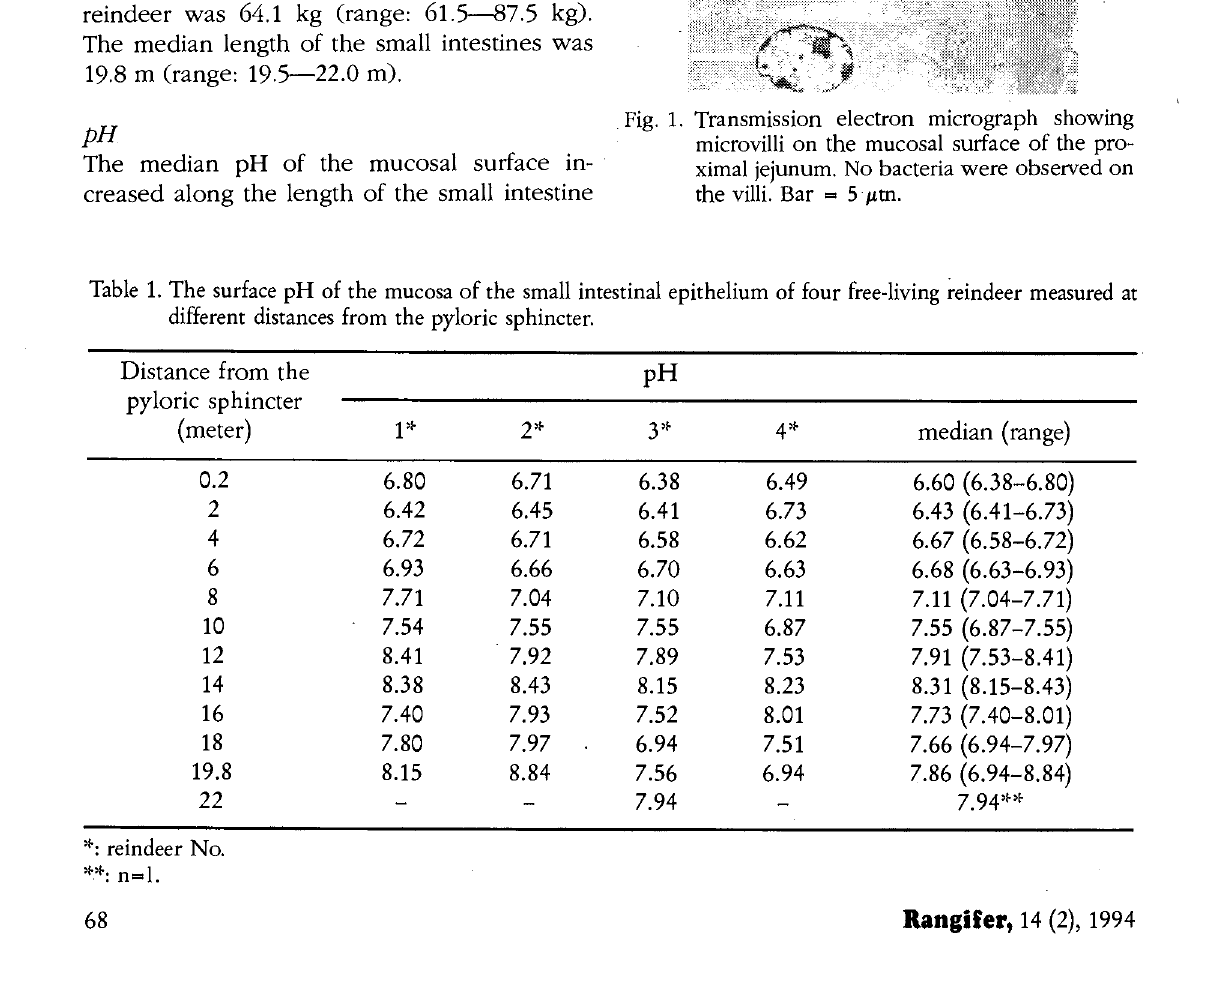
Fig. 1. Transmission electron micrograph showing microvilli on the mucosal surface of the pro ximal jejunum. No bacteria were observed on the villi. Bar = 5 /itn.